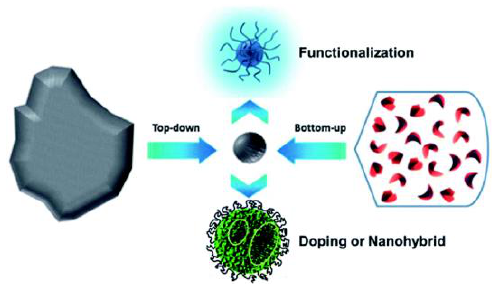
Figure 2. Schematic representation of both synthetic approaches. Reproduced with permission of [16].